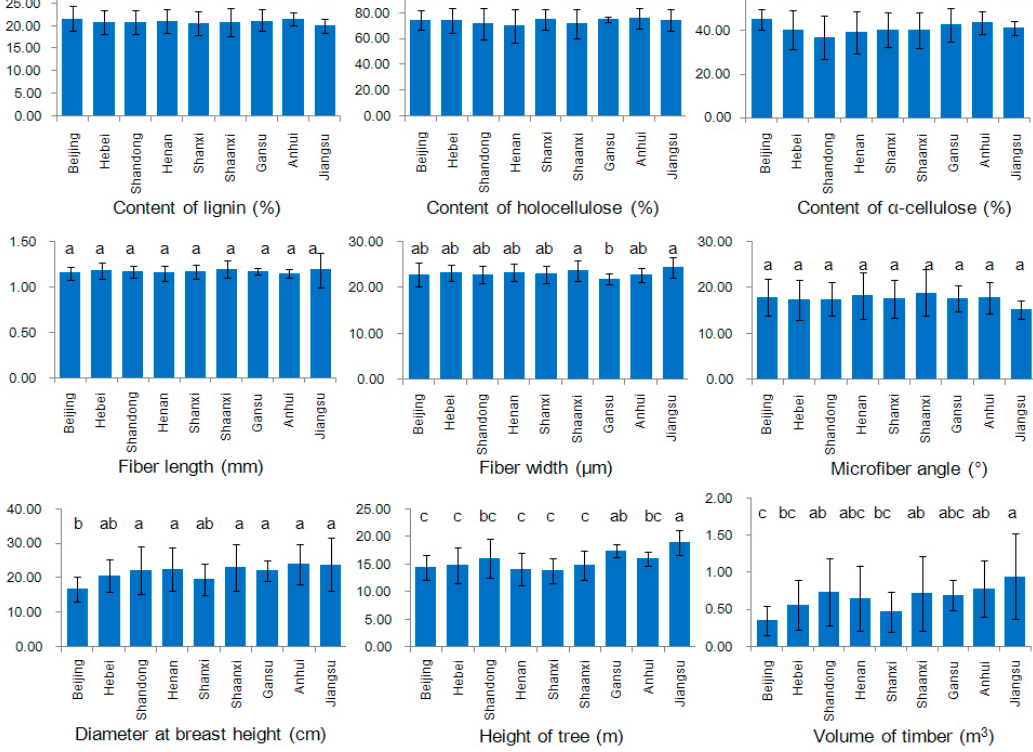
Figure 1. Differences in phenotypic traits among nine natural populations of Populus tomentosa . The x - and y -axes indicate provenance and phenotypic value, respectively. Mean ± SD (standard deviation); different letters above the bars (SD) indicate significant differences ( p < 0.05) according to Duncan’s multiple range test (within each sub-graph, it shows a significant difference between each two means if the pair of data sets have no common letter above the bars).